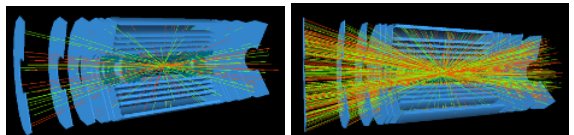
Fig. 3. The baseline layout of the new Inner Detector, traversed by simulated 23 pile-up events (left) and 230 pile-up events